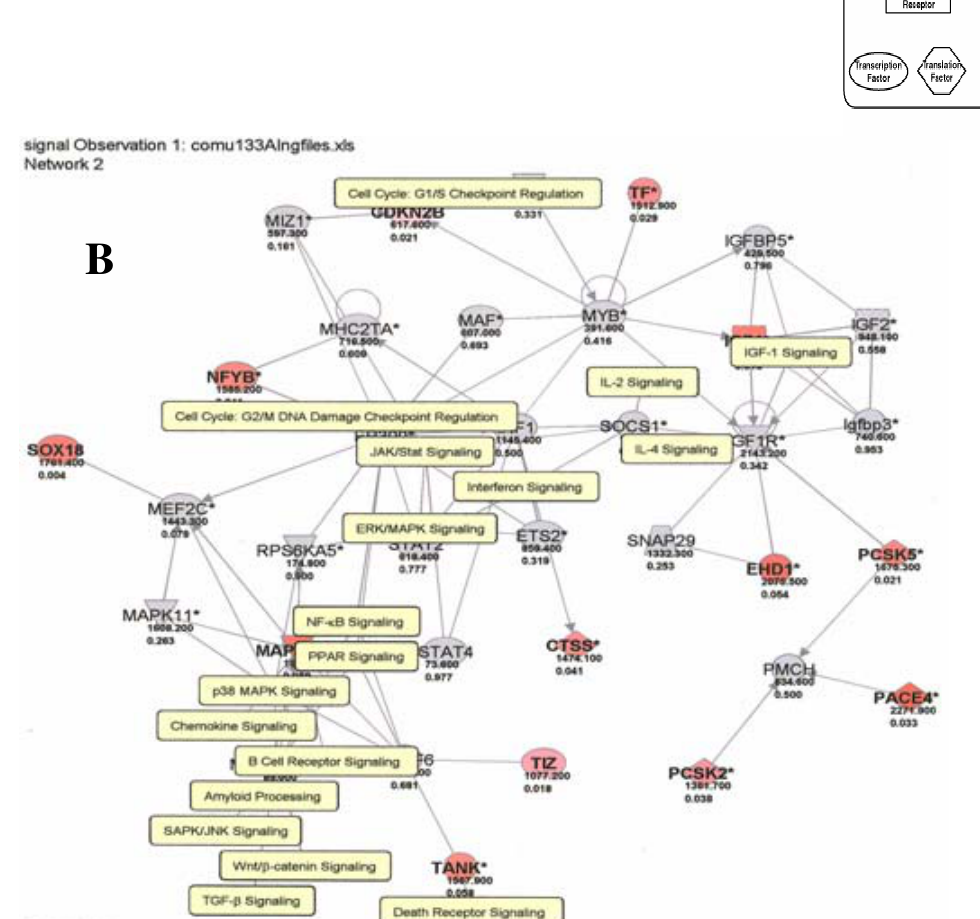
Figure 5: Genes and molecular pathways affected by mercury in HepG